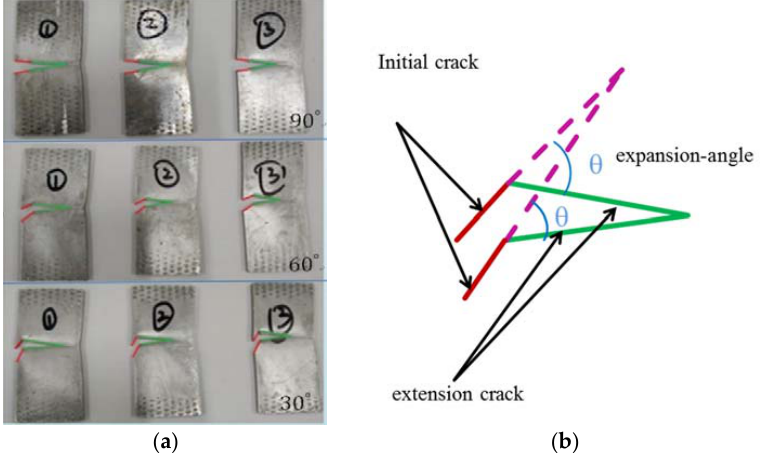
Figure 12. Crack propagation path. ( a ) Samples with extension crack; ( b ) The actual extension